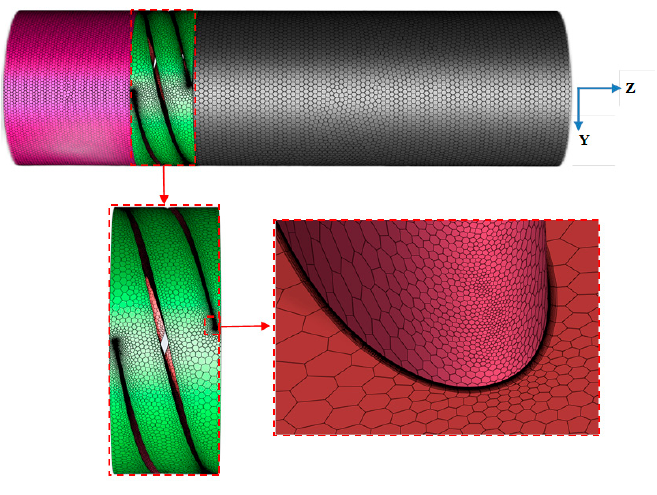
Figure 1. Three ‐ dimensional model of HAMP ( Ω denotes rotational direction).